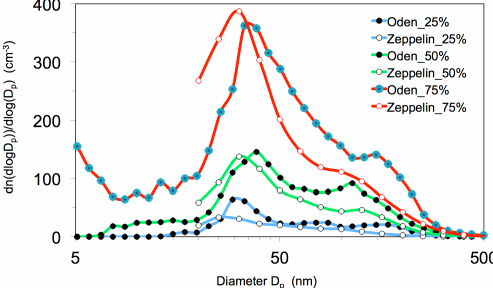
Figure 10. 25, 50, and 75% percentiles of trajectory-connected number size distributions taken during the Oden cruises in 2001 and 2008 on the icebreaker Oden and on Mt. Zeppelin, Spitsbergen.